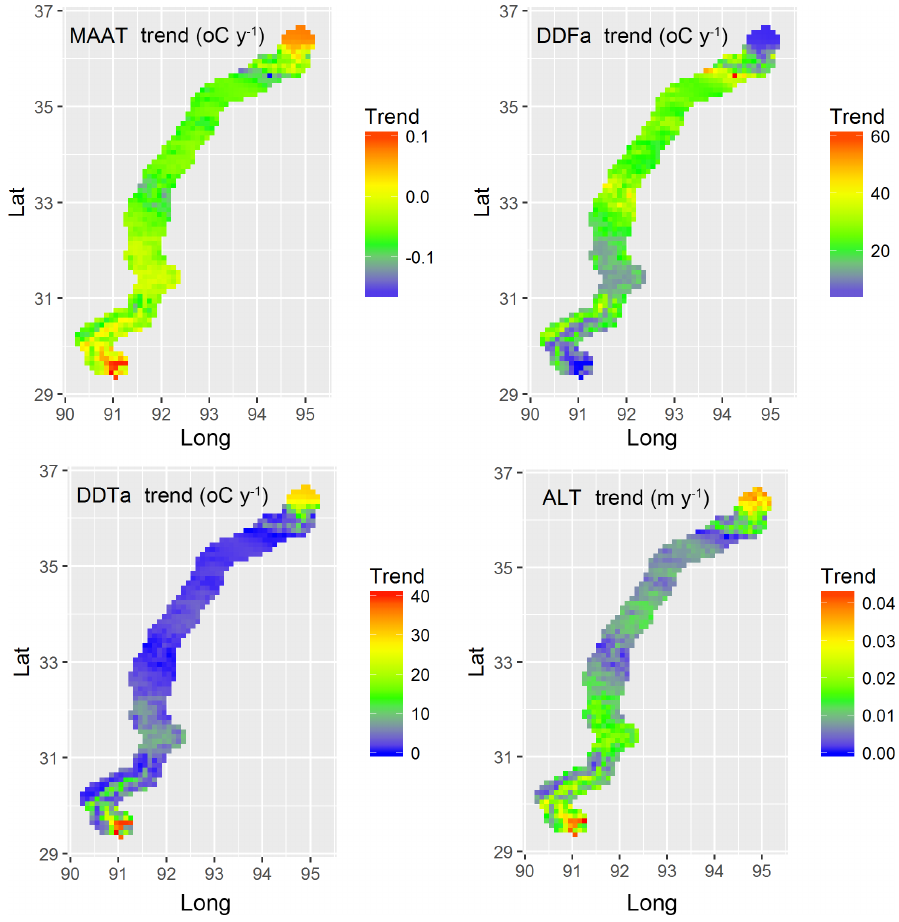
Figure 8. Spatial trend of MAAT, DDT a , DDF a , and